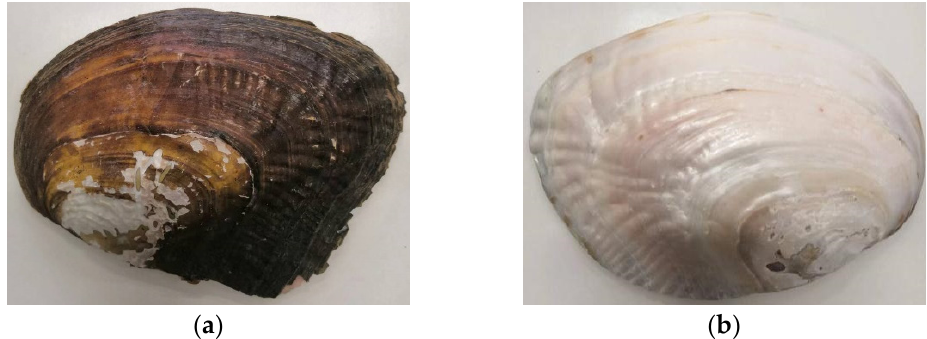
Figure 3. Seashell and stratum corneum-exfoliated seashell. ( a ) Seashell; ( b ) Stratum corneum-exfoliated seashell.